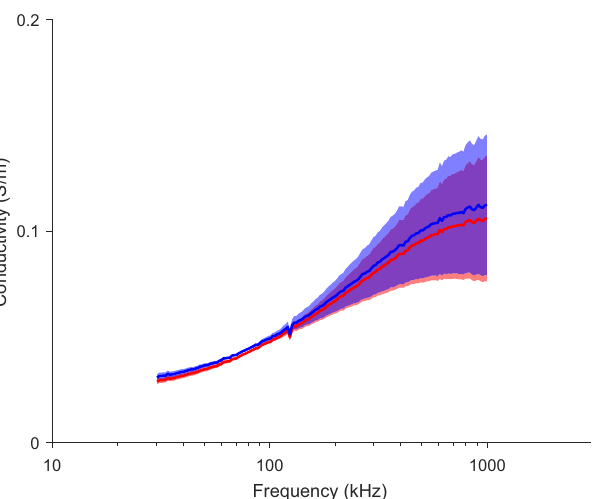
Figure 8. Estimated conductivity in longitudinal (blue) and transverse (red) direction. In situ mean ± standard deviation ( M = 3